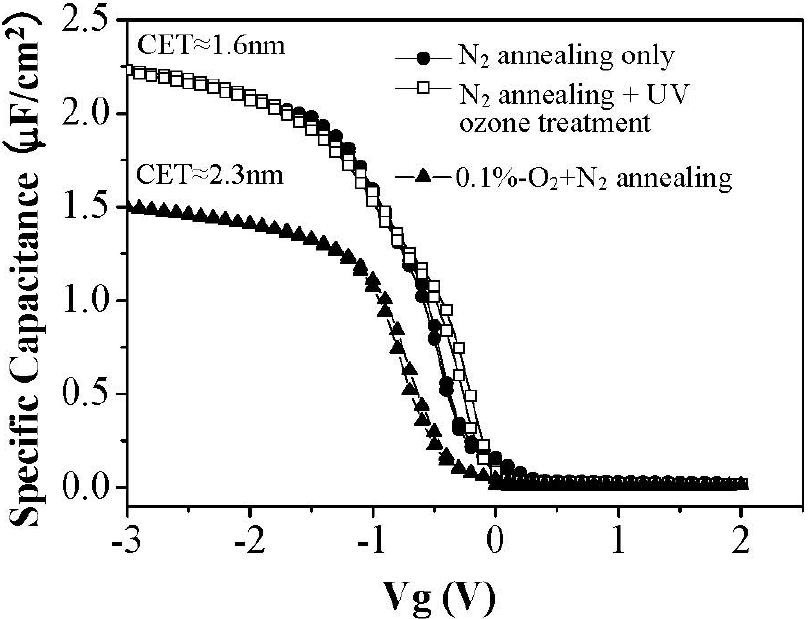
Figure 11. C–V curve (100 kHz) of Au/La ozone post treatment after N